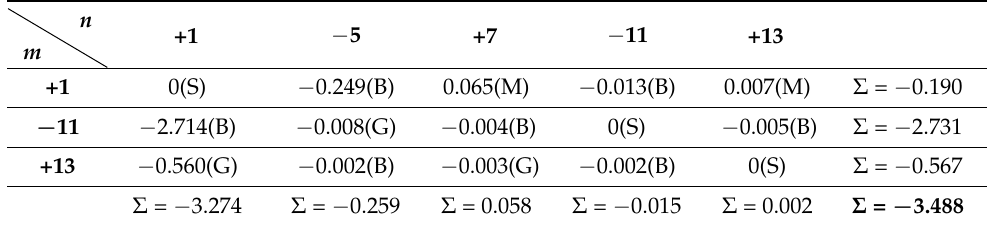
Table 3. The results of the rotor power dissipation computations for the synchronous speed (30,000 rpm) in Watt ( n —time harmonic number of voltage supply, m —spatial harmonic ordinal